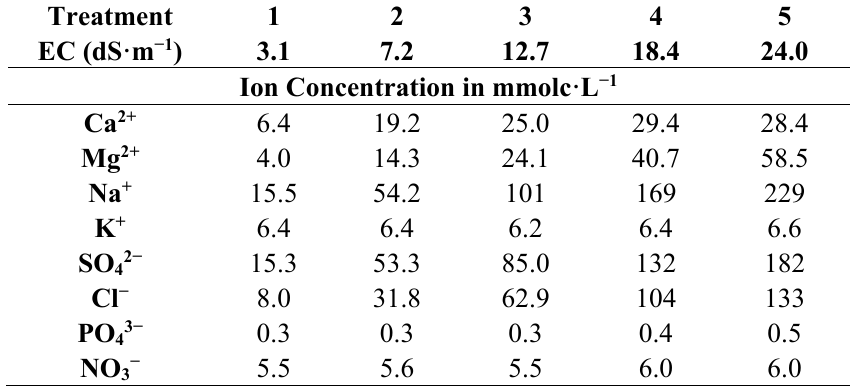
Table 1. Chemical composition of the water used in the six salinity treatments in this study. EC, electrical conductivity of irrigation water that defines each salinity level (in deciSiemen per meter); mmolc·L − 1 , millimole of charge of each cation or anion listed.